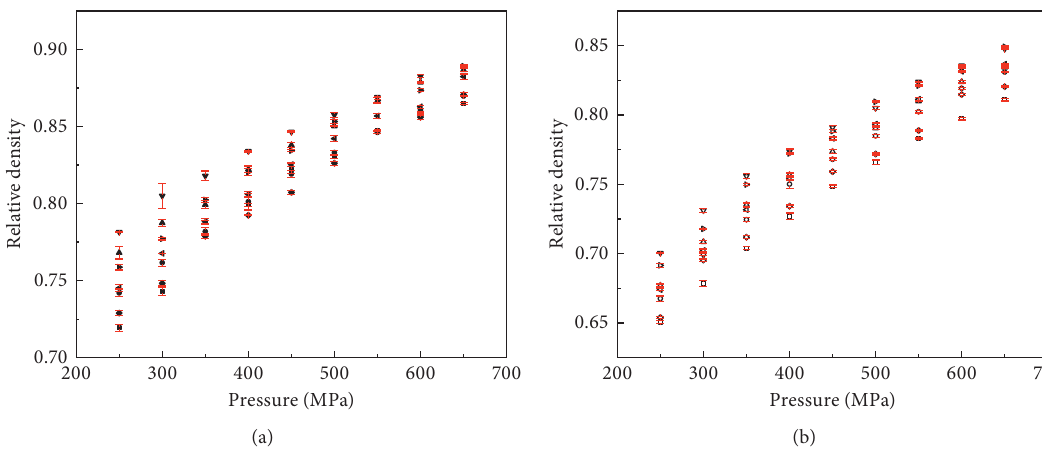
Figure 8: The green densities versus compaction pressure for (a) TiH 2 and (b) Ti HDH powders of various PSDs. ■ —0–38 μ m, ● —0–63 μ m, ▲ —0–88 μ m, ▼ —0–125 μ m, ◆ —38–63 μ m, ◀ —63–88 μ m, and ▶ —88–125 μ